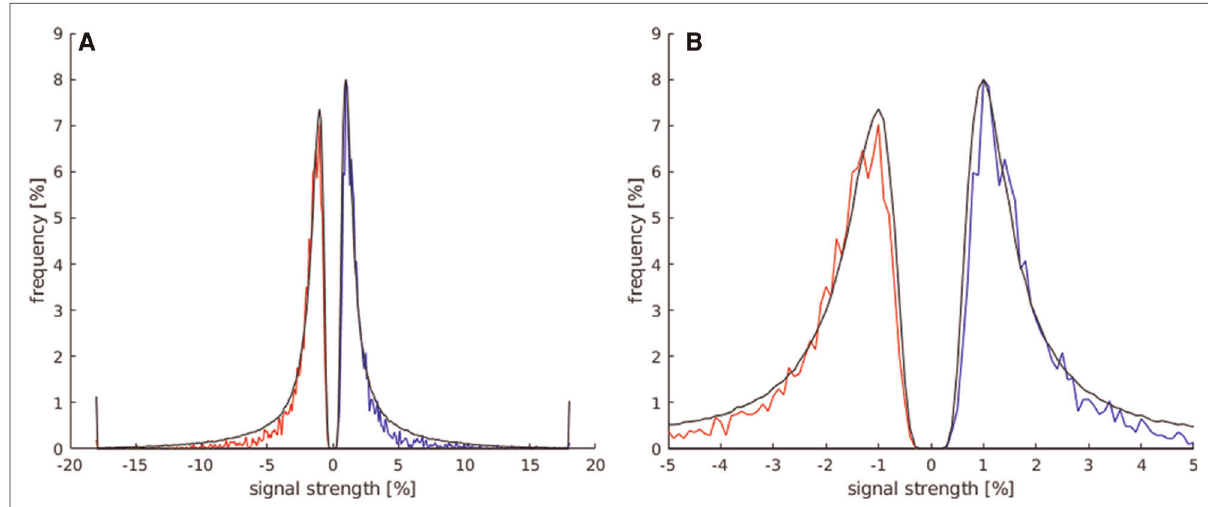
FIGURE 4 This histogram shows the comparison of the maximum and minimum signal strength values between all activated voxels of the t map (black) and the activated voxels in the LAs (red for minimum signal strength; blue for maximum signal strength). For this analysis, the data of all subjects were used. ( A ) This plot displays the frequency of voxels with signal strength values of − 20% – 20%. ( B ) Magni fi cation of the plot in ( A ) ( − 5% – 5% signal strength) to better illustrate the frequency distribution in the lower signal strength ranges.